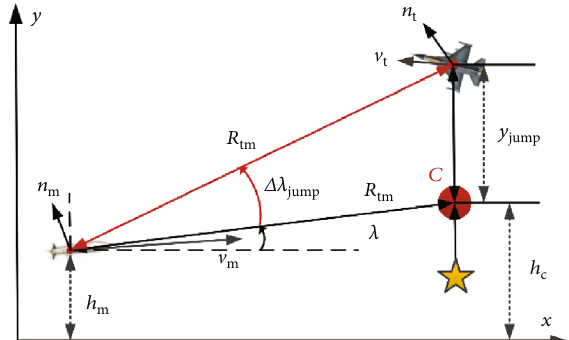
Figure 4: Schematic diagram of the step-jump phenomenon of the trace